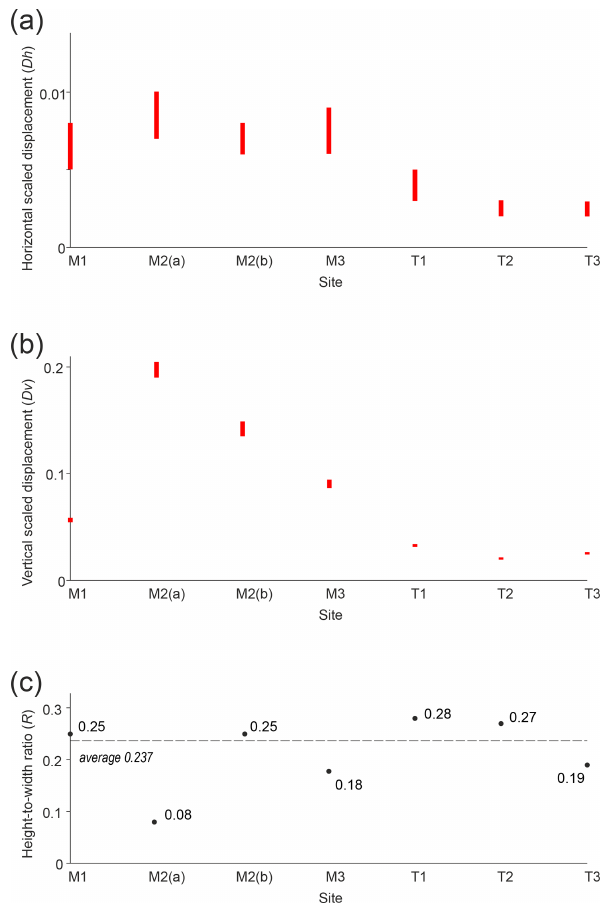
Figure 9. Scaled horizontal displacement Dh (a) , scaled vertical displacement Dv (b) , and height-to-width ratios R (c) in the study sites. For Site M2, two endmember fault displacement interpreta- tions of the Melas Chasma–Candor Chasma central depression are given: option (a) corresponds to the fully tectonic interpretation pro- posed by Mège and Bourgeois (2011) and option (b) to a mixed tectonic–glacial interpretation (Gourronc et al., 2014). Dashed line in (c) indicates the average height-to-width ratio when the option (b) of site M2 is